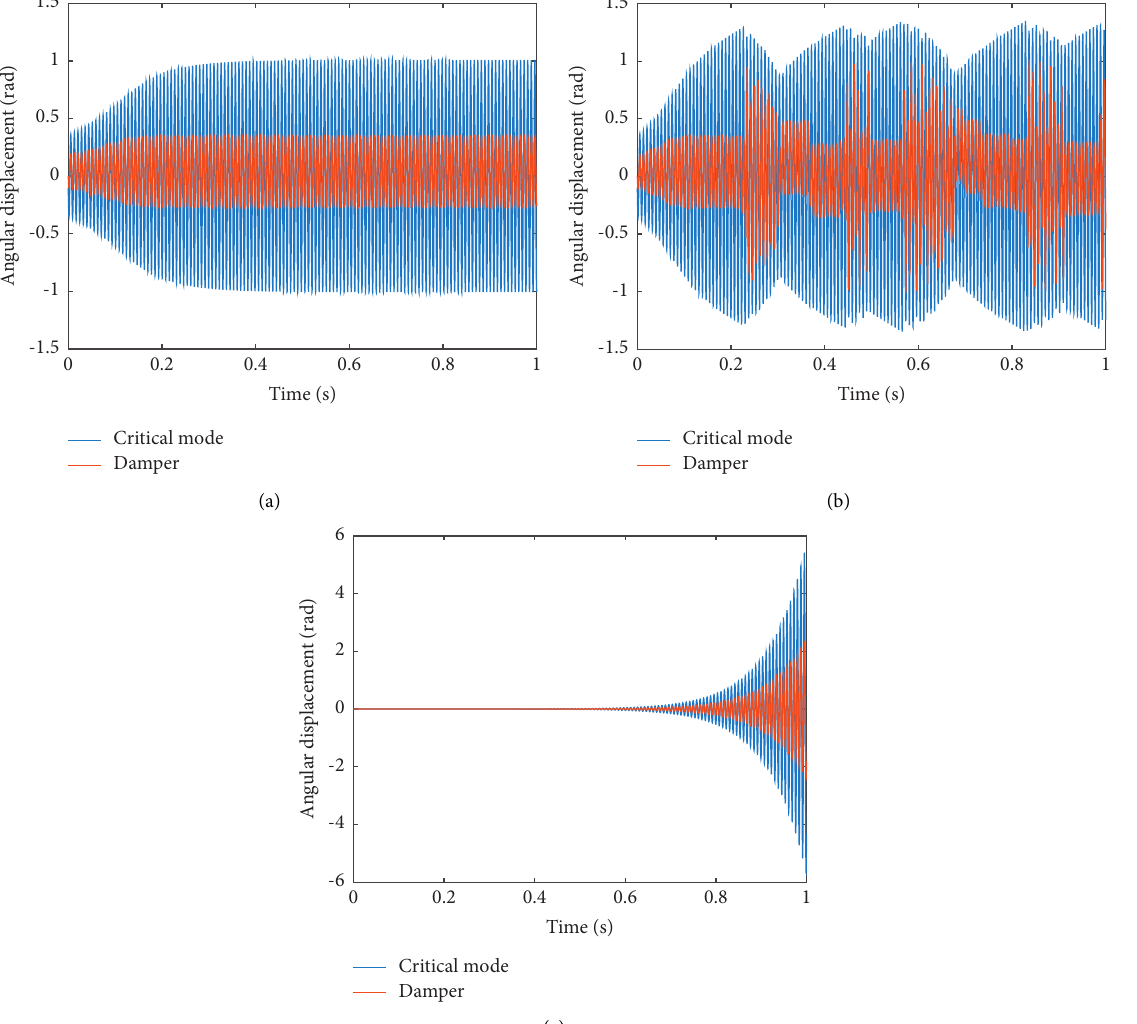
� 0 . 7%, (b) D � 1 . 2%, and (c) D i i